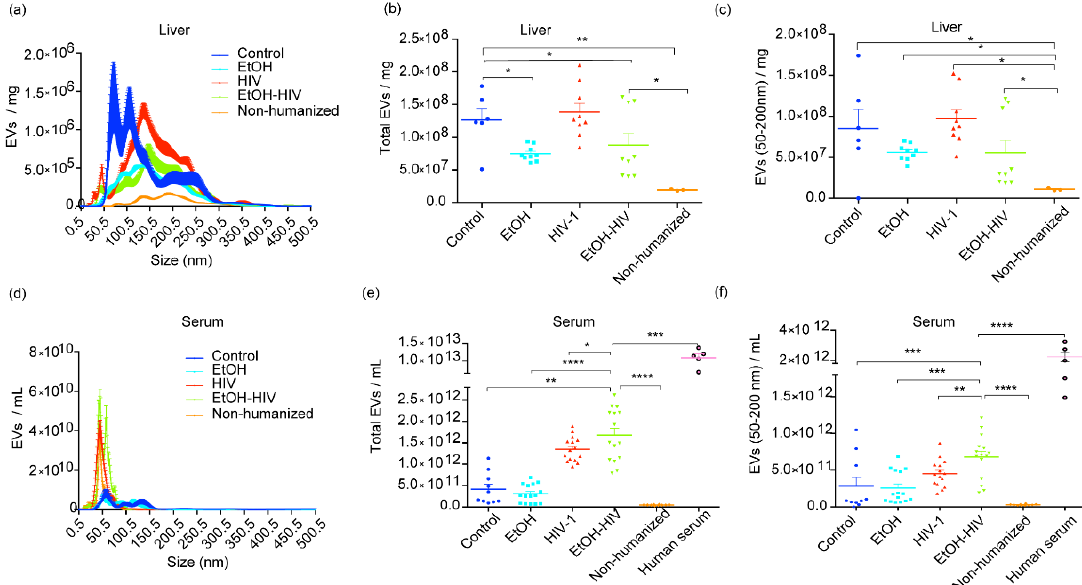
Figure 2. Hepatocyte-derived EVs in the liver and serum from liver-humanized and non-humanized mice. ( a ) The size distribution of hepatocyte-specific EVs for the size range 0.5–500.5 nm in the liver from humanized control, EtOH, HIV-1 and EtOH–HIV, and non-humanized mice. ( b ) Graph showing the concentration of total human hepatocyte specific EVs obtained from the livers. ( c ) Graph showing the concentration of EVs in the size range of sEVs (<200 nm) obtained from the livers. ( d ) The size distribution of human hepatocyte specific EVs in the serum. ( e ) Total human hepatocyte specific EVs in the serum. ( f ) The serum concentration of human hepatocyte EVs in the size range of sEVs. The single dot represents the concentration of EVs in one capture in NanoSight. Equal amounts of livers and serum from untreated and treated mice were used as the starting material to isolate total EVs. Non humanized mice served as a negative, and human serum as positive to the human-specific EVs. All conditions and dilutions were kept identical for all the treatment groups. NanoSight NS300 was used to assess concentration after adjusting for dilutions. Data for the control group were derived from the single control mouse and two pooled control mice. Non-humanized mice data were derived from pooled samples of three mice. Statistical significance between treatment groups is indicated by asterisk(s) and determined by one-way ANOVA (**** p ≤ 0.0001, *** p ≤ 0.001, ** p ≤ 0.01, and * p ≤